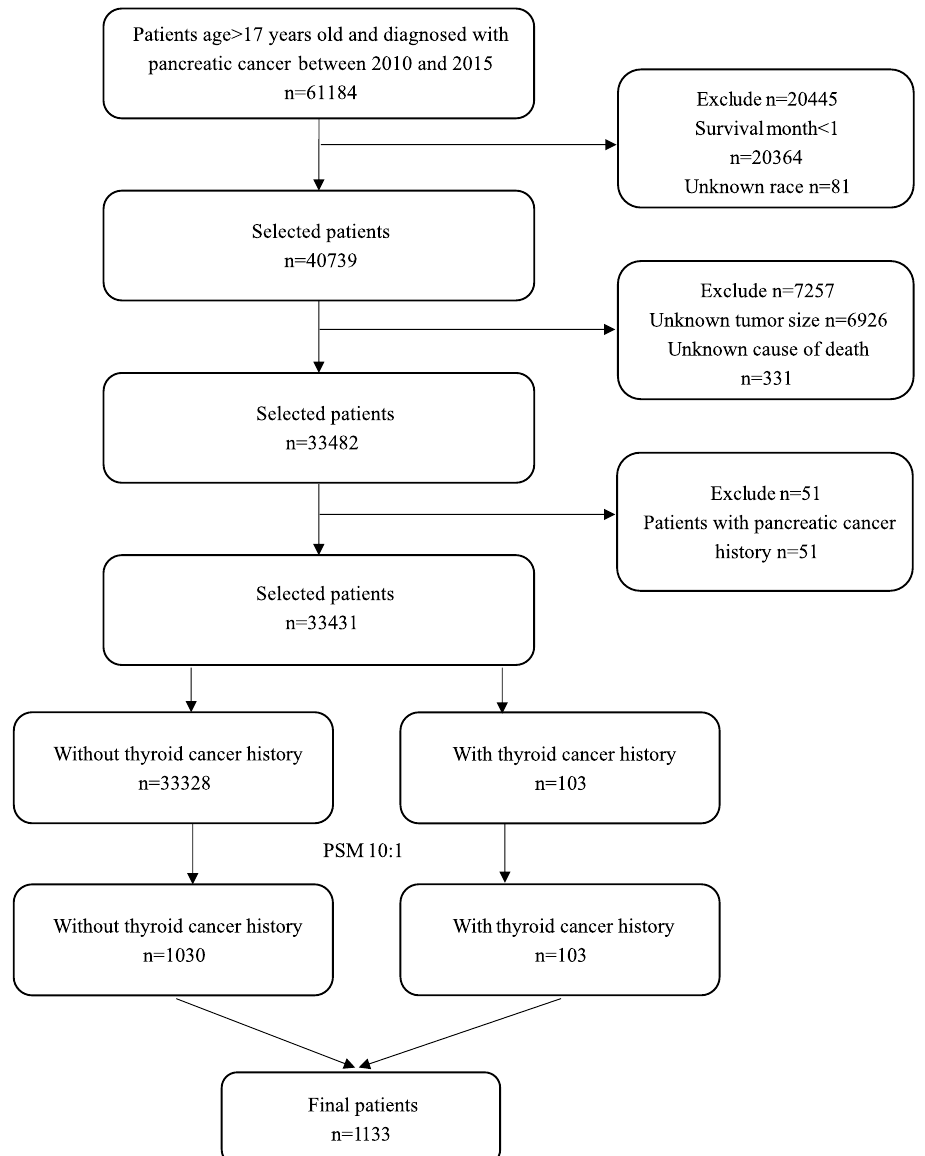
Figure 1. Flowchart of patients’ selection. PSM propensity score